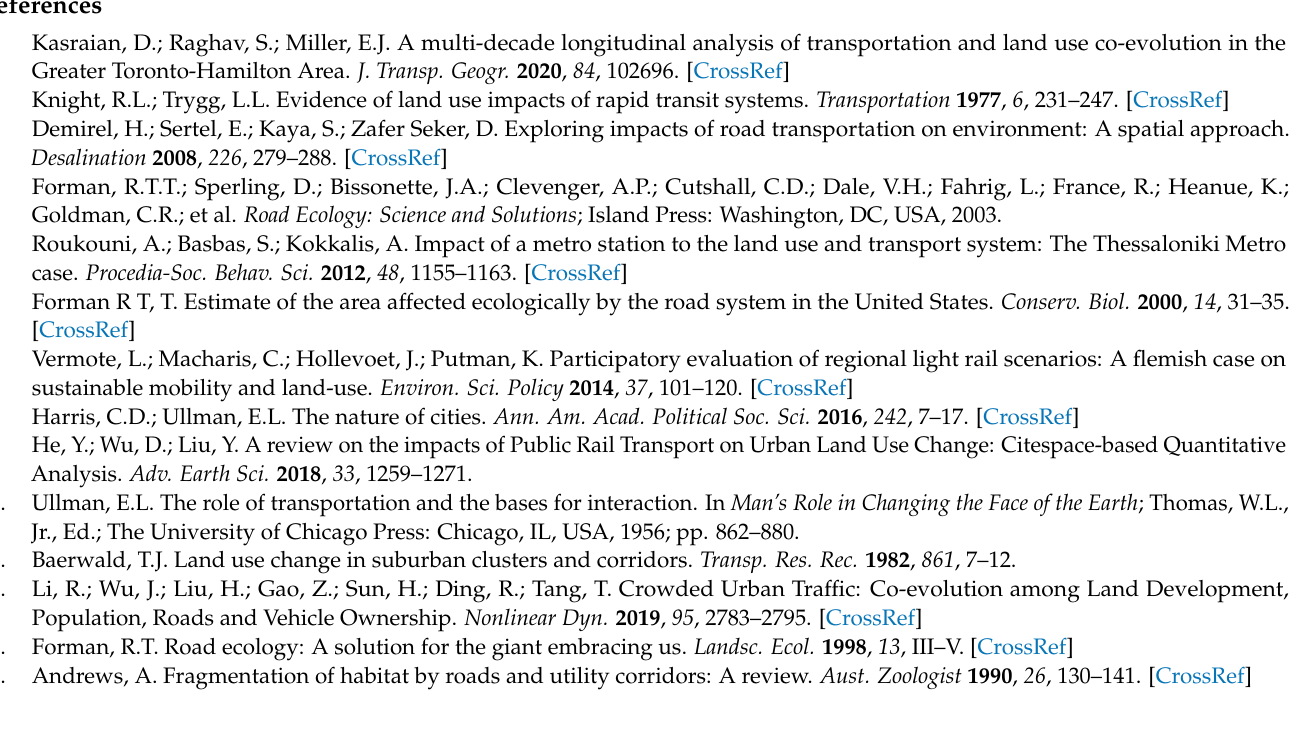
Figure S1. Major land use types and changes in the 30 km buffer areas of the Kunming–Bangkok Highway in 2004–2018. Figure S2. Major land use types in the 30 km buffer areas of the Kunming– Bangkok Highway in 2004, 2013, and